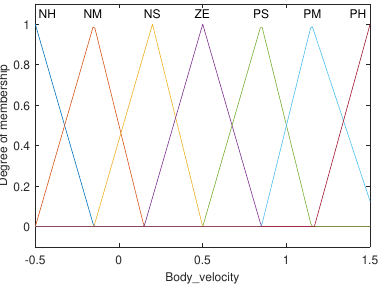
Figure 4. Membership Function of i / p variable “Body Velocity”